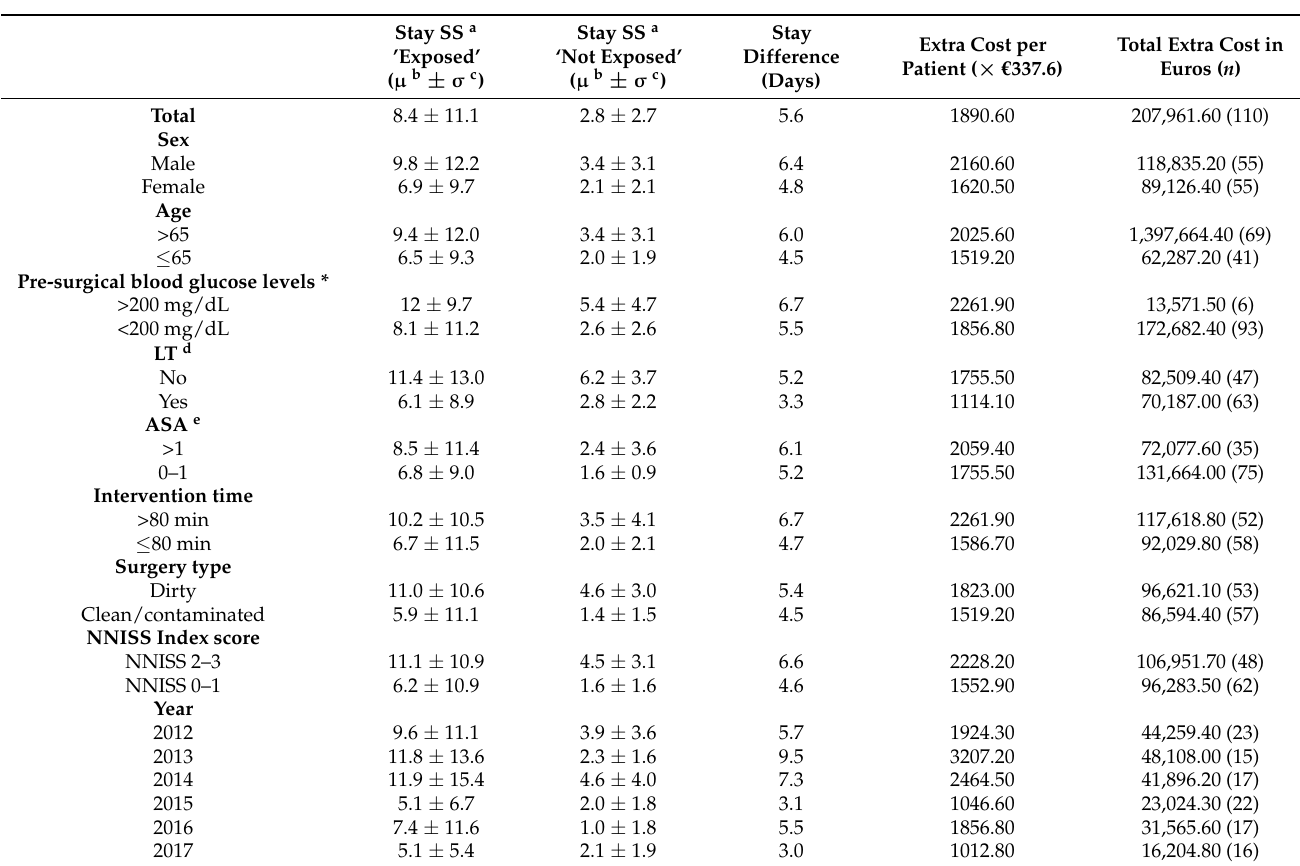
Table 3. Analysis of the costs associated with the increased postoperative stay related to surgical site